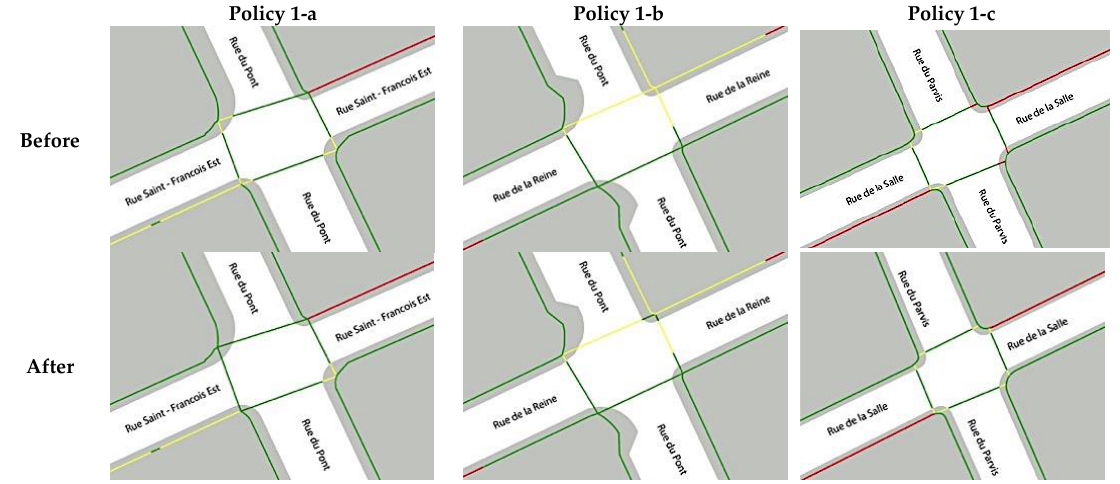
Figure 8. Visualization of implementation of different policy changes on a curb cut.